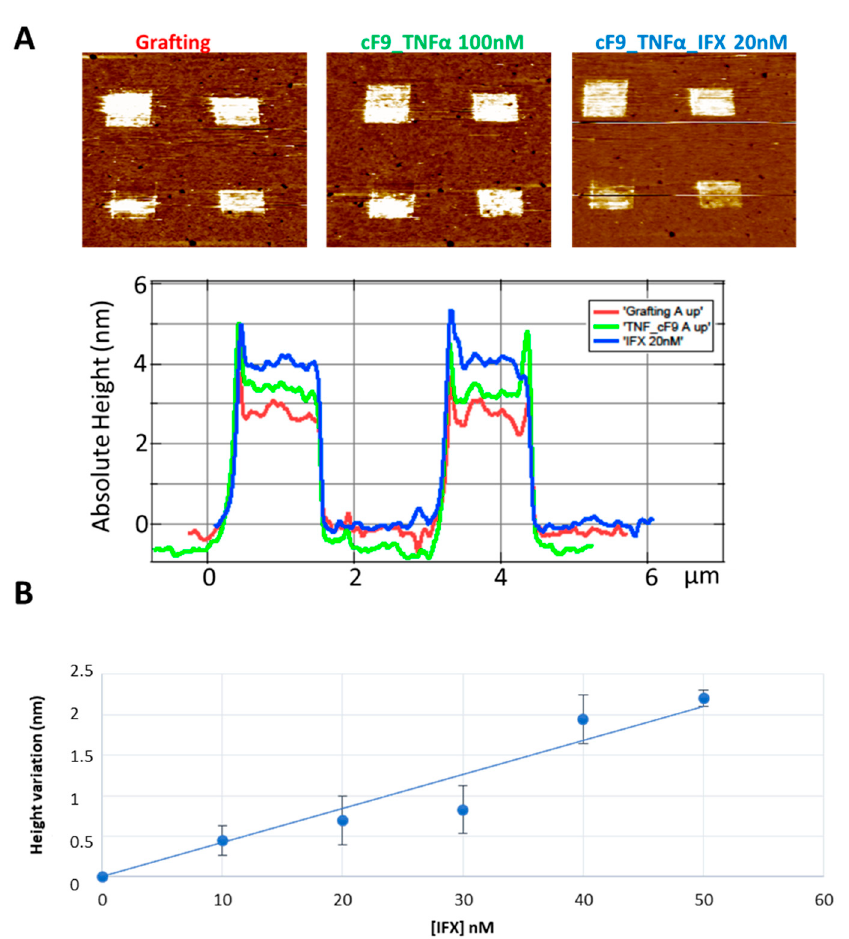
Figure 3. ( A ) An example of DNA nanostructures characterization by AFM topography: different DNA patches profiles with different height taken from AFM images (red line: ssDNA; green line: TNF-cF9 conjugate; blue line: infliximab (IFX) 20 nM); ( B ) the calibration line obtained in healthy donor sera spiked with IFX at different concentrations.